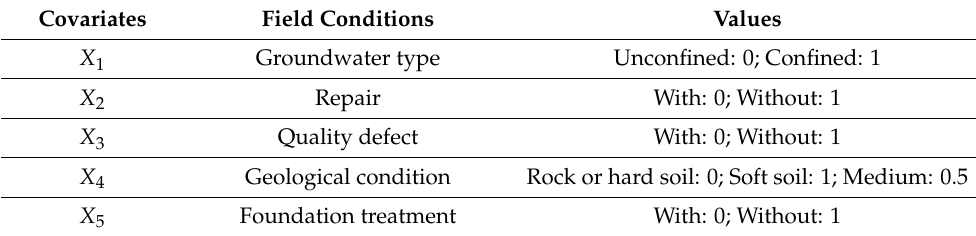
Table 3. Field condition covariates and corresponding values.